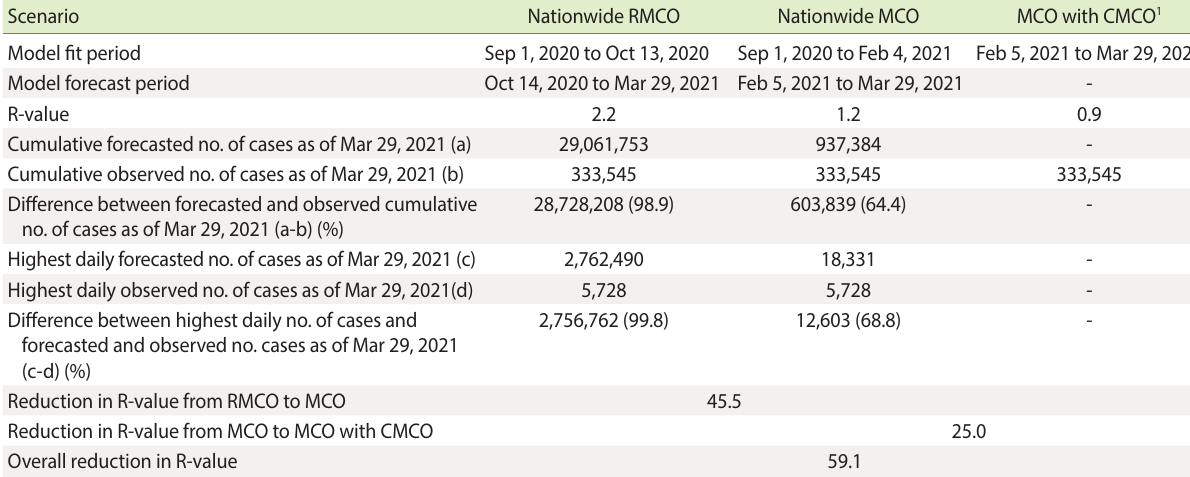
Table 2. Estimated R-values generated by the SEIR model for three scenarios Scenario